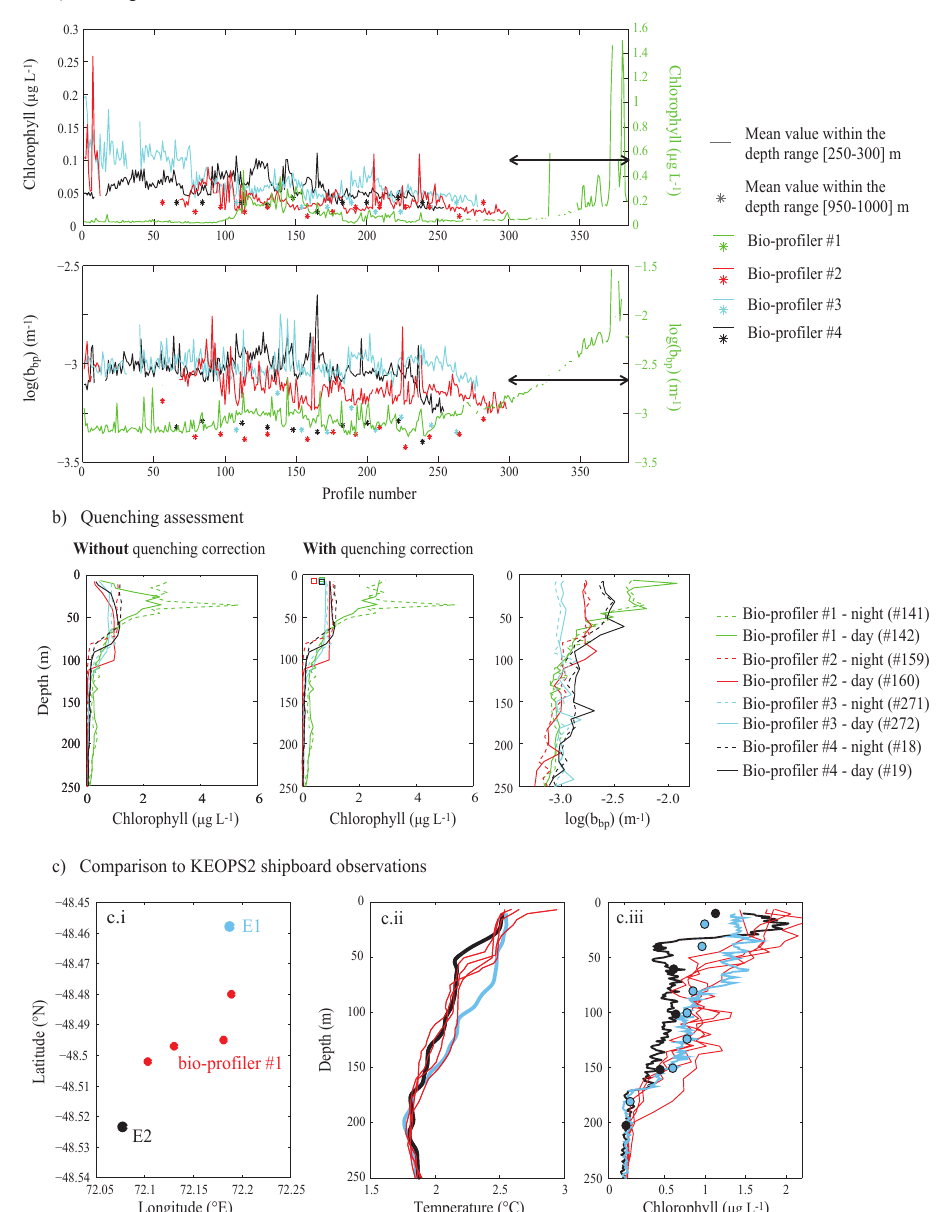
Figure 2. (a) Assessment of bio-optical sensor stability from temporal evolution of chlorophyll and particulate backscattering values averaged over two depth ranges: 250–300 (lines) and 950–1000m (stars). Arrows indicate profiles considered to be affected by bio-fouling, which were not used in further analysis. (b) Illustration of quenching corrections, showing pairs of successive night/day profiles (day: continuous lines; night: dashed lines). Panels show, for each bio-profiler, chlorophyll profiles without quenching correction (left), chlorophyll profiles with quenching correction (middle), and associated particulate backscattering profiles (right). Squares in the middle panel represent threshold values of the lowest surface chlorophyll concentration for the night profiles of each bio-profiler (#1: 0.7; #2: 0.4; #3: 0.65; #4: 0.7µgL − 1 ) . These thresholds were used to flag day profiles with surface chlorophyll concentrations still below them after the quenching correction (see Table 3 and Figs. 7 (squares), 8 (red circles), and 10 (squares)), for which quenching might have been under-corrected. (c) Comparison of bio-profiler #1 fluorescence Chl a estimates to shipboard results obtained by the KEOPS2 project: (c.i) location of KEOPS2 stations E1 (blue symbols) and E2 (black symbols) along a quasi-Lagrangian track followed by bio-profiler #1 (red symbols); (c.ii) temperature profiles showing similar structures of the ship and bio-profiler sampled water columns; (c.iii) fluorescence profiles (lines) showing that the bio-profiler provided similar fluorescence results to the ship CTD-mounted sensor, and that both exhibited complex relationships to Niskin bottle total chlorophyll a sample values (dots; see text for further